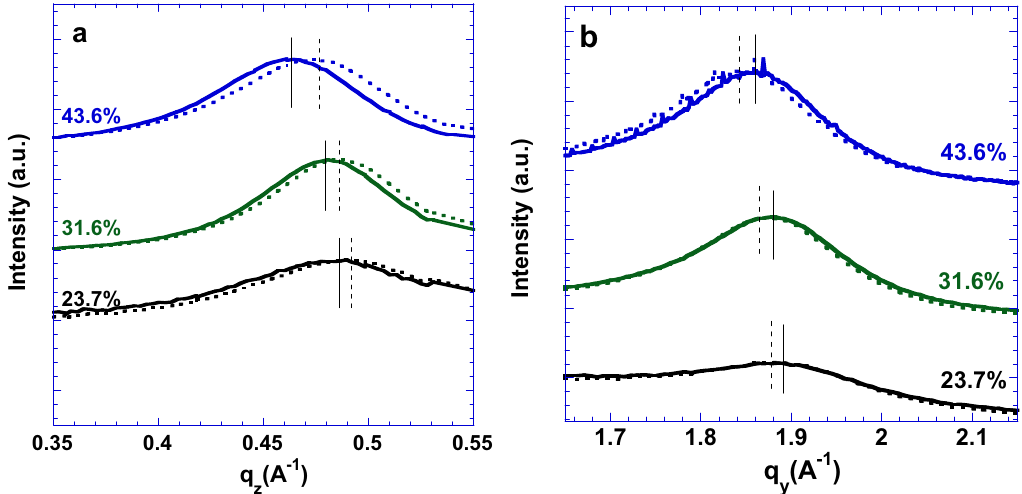
Figure 4. The 1D GIWAXS patterns along ( a ) q z , and ( b ) q y of the PEDOT:Tos thin films at the doping levels of 23.7%, 31.6%, and 43.6% under the nitrogen flow pressure (dash line) and under no nitrogen flow pressure (solid line).